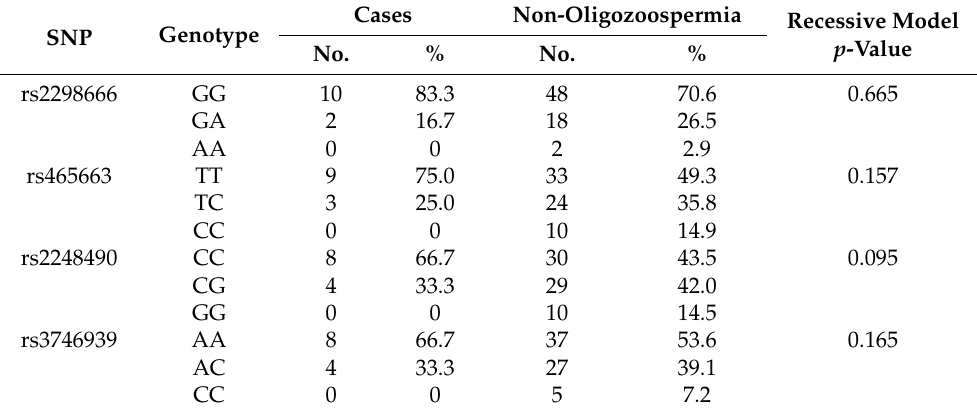
Table 2. Associations between genetic variants of the WDR4 gene and